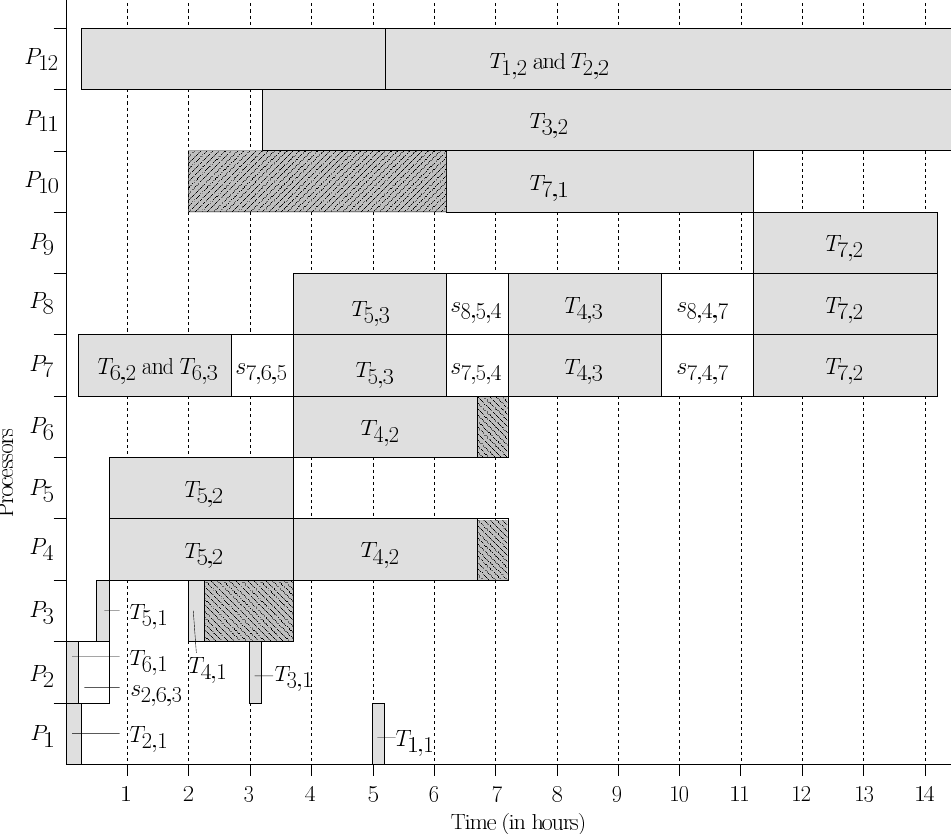
and J j is denoted by s i,j 1 2 1 ,j 2